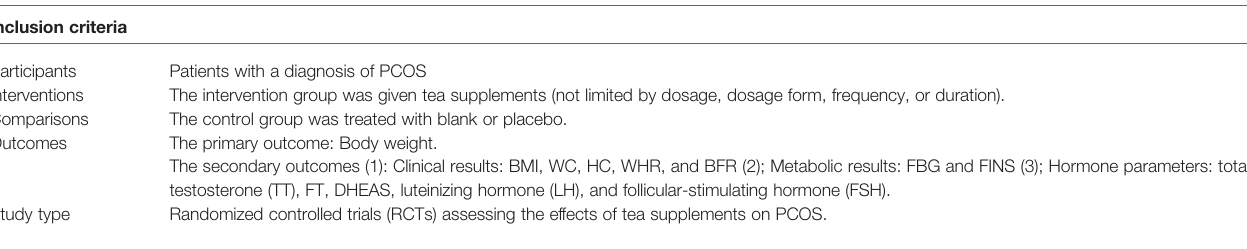
TABLE 1 | Eligibility